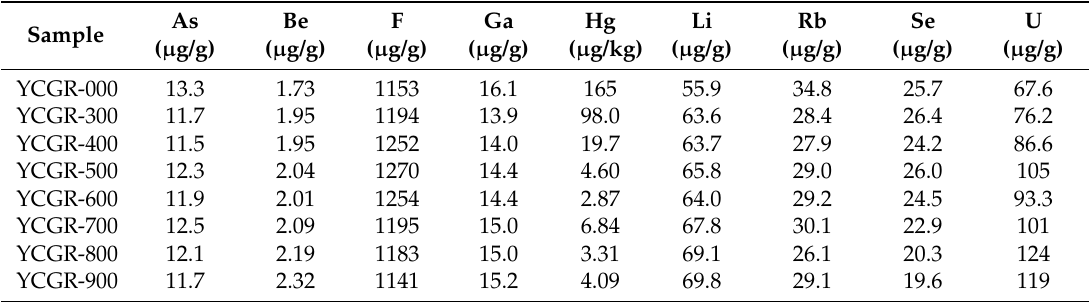
Table 4. Trace element (TE) concentrations in raw coal and chars obtained from pyrolysis at different